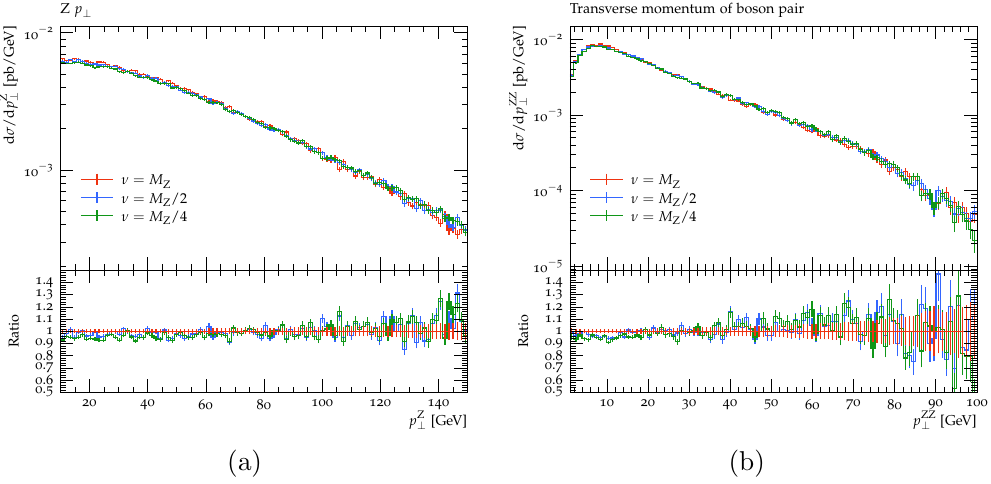
Figure 10 . (a) Transverse momenta of the Z 0 bosons and (b) transverse momentum of the Z 0 Z 0 pair as given by equation (3.22) for three di(cid:11)erent values of (cid:23) . The (cid:23) = M Z setup is the reference in the ratio plots. The histograms are not normalised to unity.